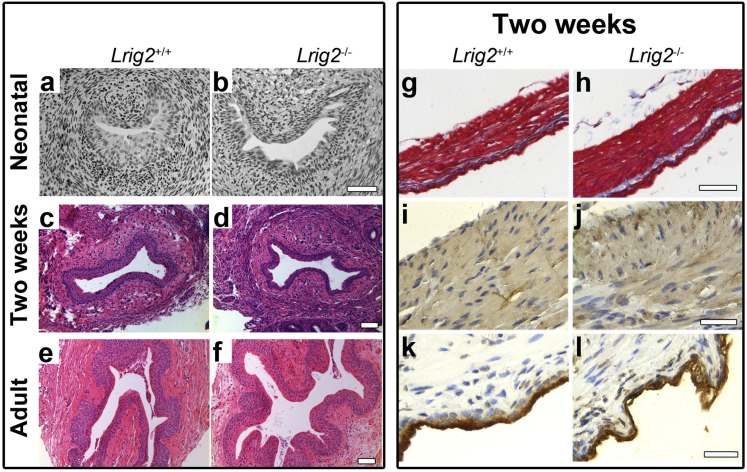
Neonatal and 2-week urinary bladder histology. (A–F) Bladder outflow: 5-μm paraffin sections cut transversely across the outflow comparing wild-type with leucine-rich repeats and Ig-like domains 2 (Lrig2)–/– mutants at neonatal, 2-week, and adult stages. All had patent outflow tracts. Bars = 100 μm. (G–L) Bladder body: 2-week bladder sections were reacted with Masson’s trichrome (G and H; muscle and urothelium = red and collagen = light blue), or muscle immunostained (brown) for α-smooth muscle actin (I,J), or urothelium immunostained (brown) for uroplakin II (K,L). Note that staining patterns were similar in Lrig2–/– and Lrig2+/+ bladders. Bars = 50 μm.